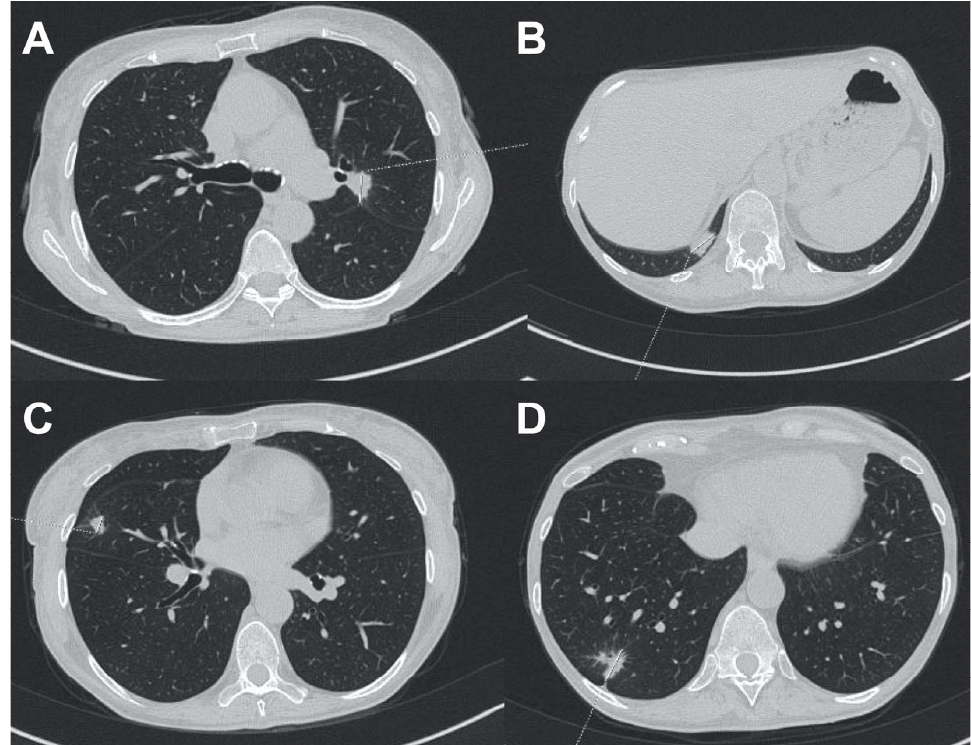
Figure 5. ( A – D ) . CT of patient 2, with multiple pulmonary nodules found in the right and left lungs.